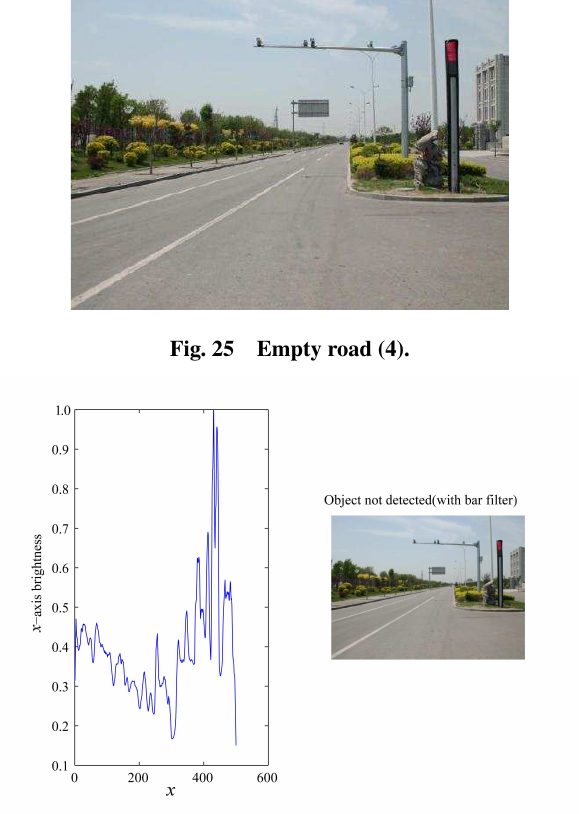
Fig. 23 Horizontal axis’ brightness values and search result (with bar filter) according to Fig. 22.